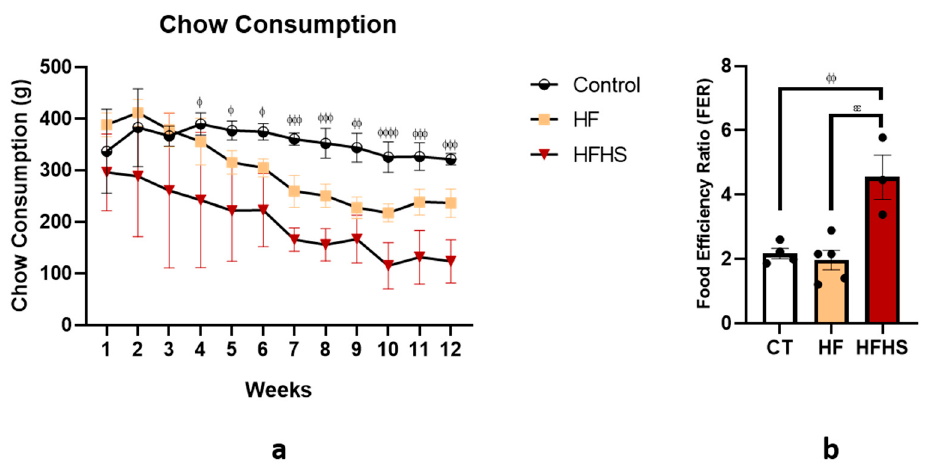
Figure 3. The graphic in ( a ) represents the food consumption during the twelve weeks of treatment. The histogram in ( b ) shows the Food Efficiency Ratio (FER) between the different groups. Data are presented as the mean ± SEM. φ p < 0.05; φφ p < 0.01; φφφ p < 0.001; and φφφφ p < 0.0001 HFHS versus controls; and εε p < 0.01 HFHS versus HF. Dark circles represent the Food Efficiency Ratio (FER) of each animal.